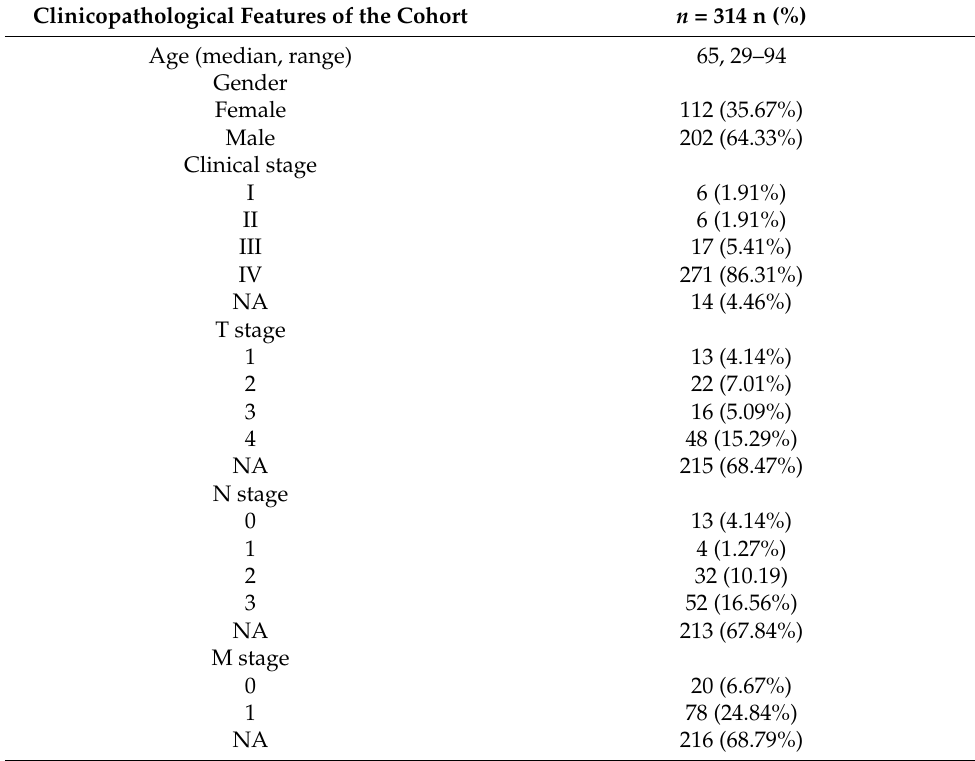
Table 1. Clinicopathological features of the